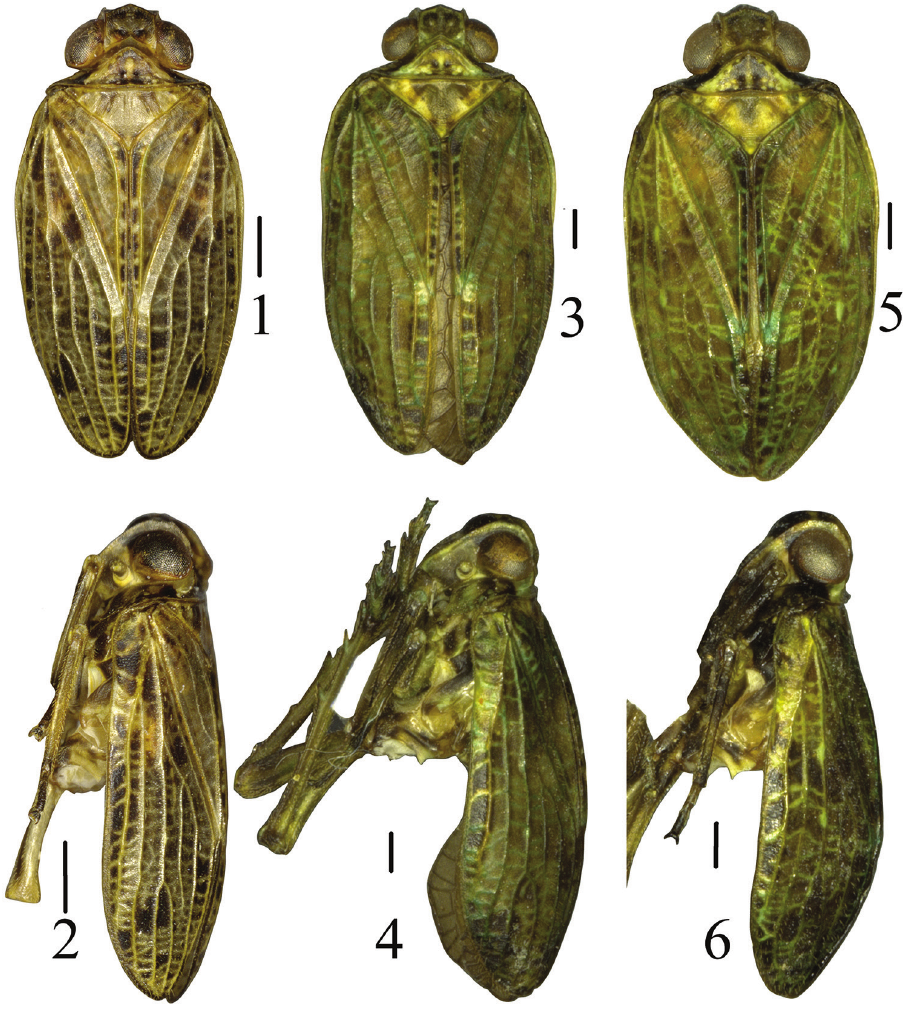
Figures 1–6. Dorsal habitus of Tetricodes species. 1–2 Tetricodes ansatus Chang & Chen, sp. n. 3–4 Tetri- codes parvulus Chang & Chen, sp. n. 5–6 Tetricodes similis Chang & Chen, sp. n.. Scale bars = 0.5 mm.